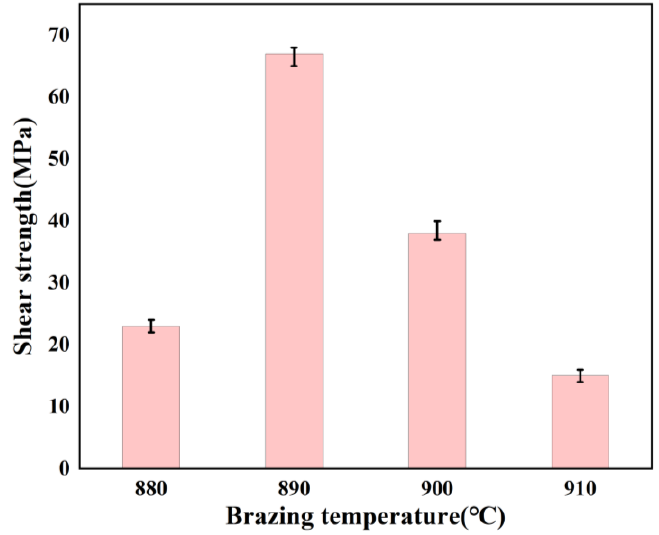
Figure 6. The shear strength of the joint brazed for 15 min at different temperatures.